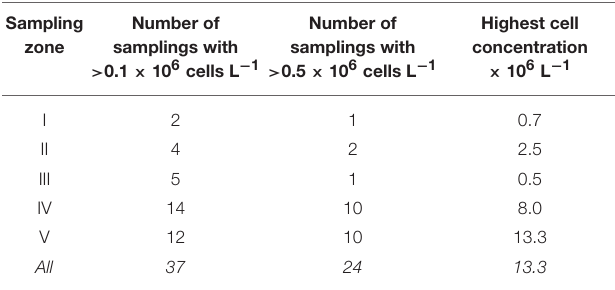
TABLE 2 | Linear dimensions of C. subsalsa from Guanabara Bay based on 1,776 images of live cells obtained with the FlowCam ®